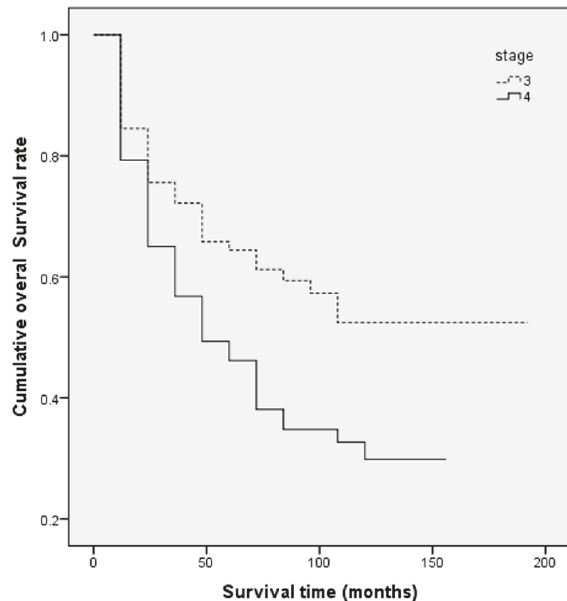
Figure 3: Laryngeal cancer overall survival according to different clinical stages among patients diagnosed with laryngeal cancer, South of Iran, 2000–2015 ( 𝑃 value < 0.002).